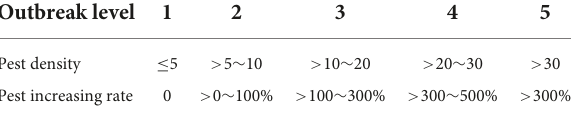
TABLE 2 Grading indexes of pest outbreak in cotton field.